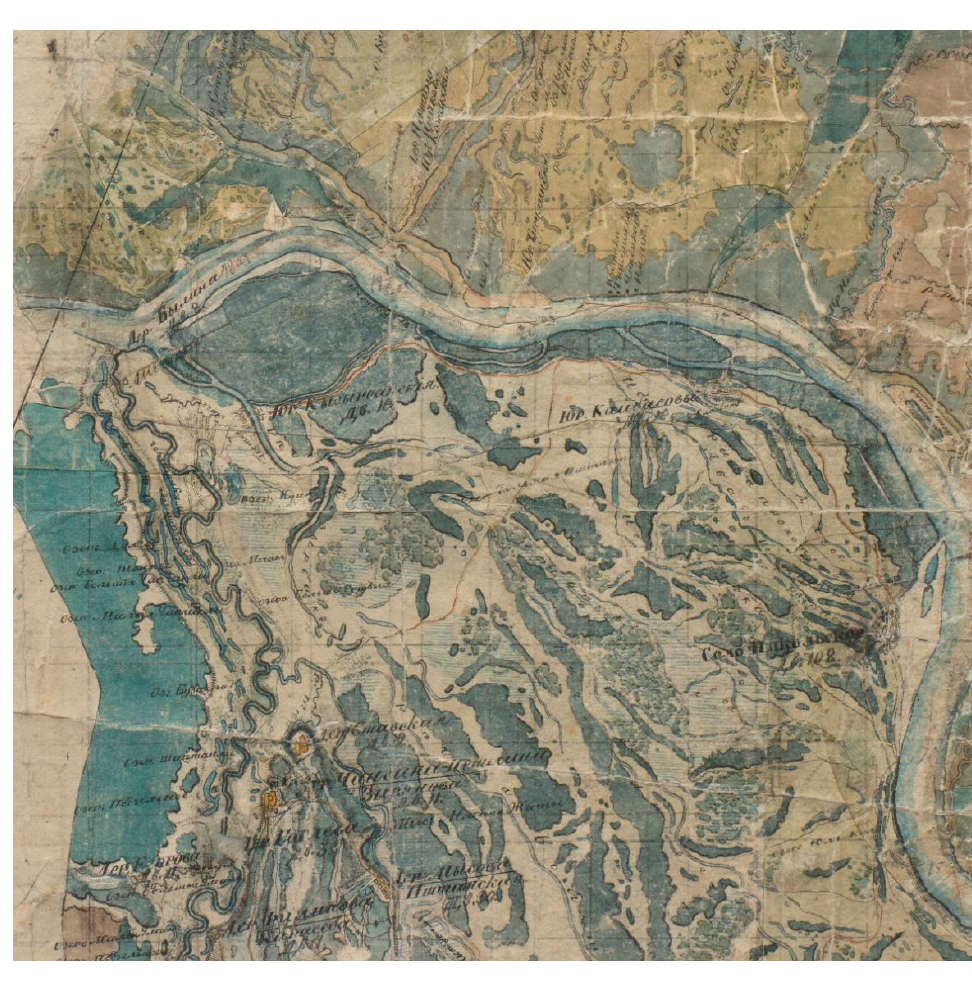
Figure A1. 1830 map of Tomsk province.